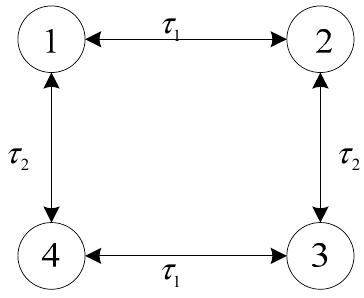
Figure 1. Experiment 1 system communication topology.